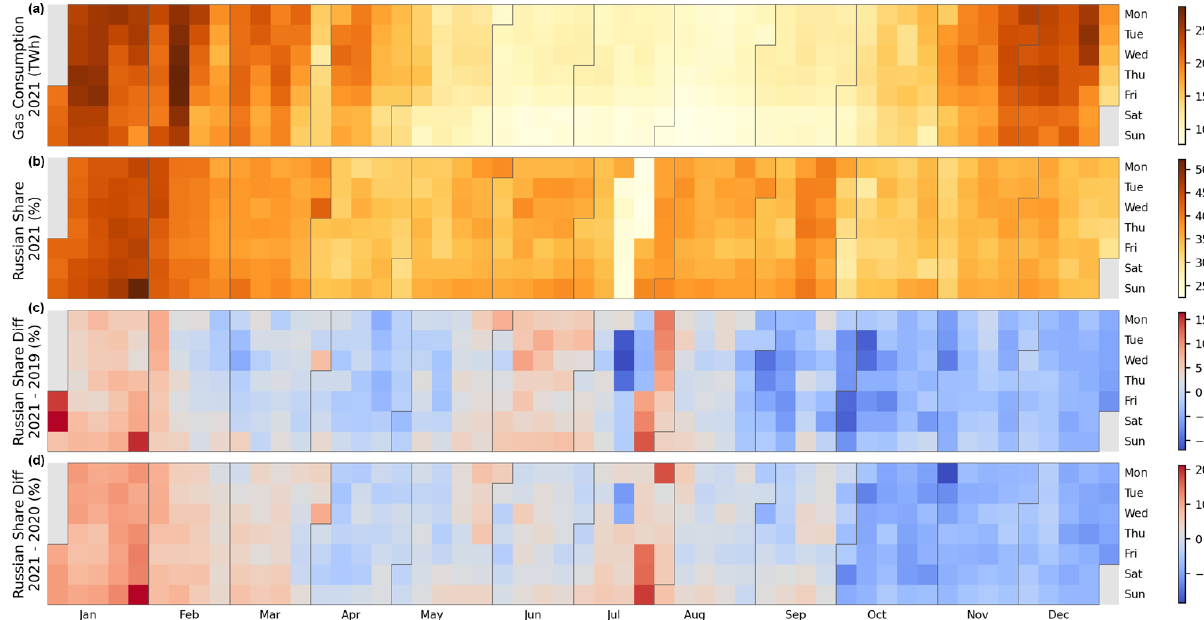
Figure 6. Calendar plot of 2021 for the gas consumption and Russian supply shares in the EU27 and UK. The figure panels show the calendar plot (each box represents a day, and each column present a week) for gas consumption in the EU27 and UK (a) , the mean Russian supply share (b) , the difference in the mean Russian supply share between 2021 and 2019 (as the non-COVID period) (c) , and the difference between 2021 and 2020 (as the peak-COVID period) (d)